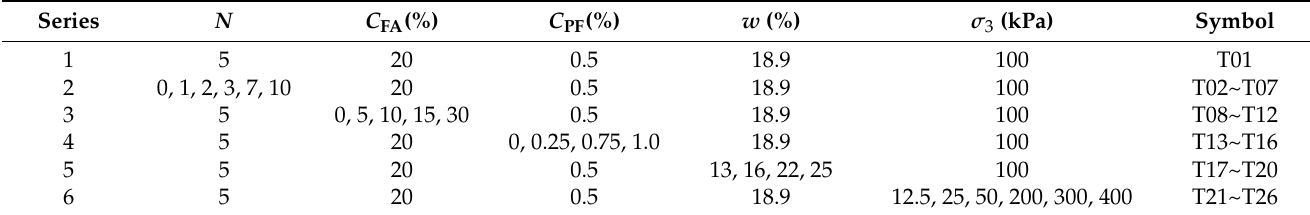
Table 4. Summary of dynamic triaxial test conditions.